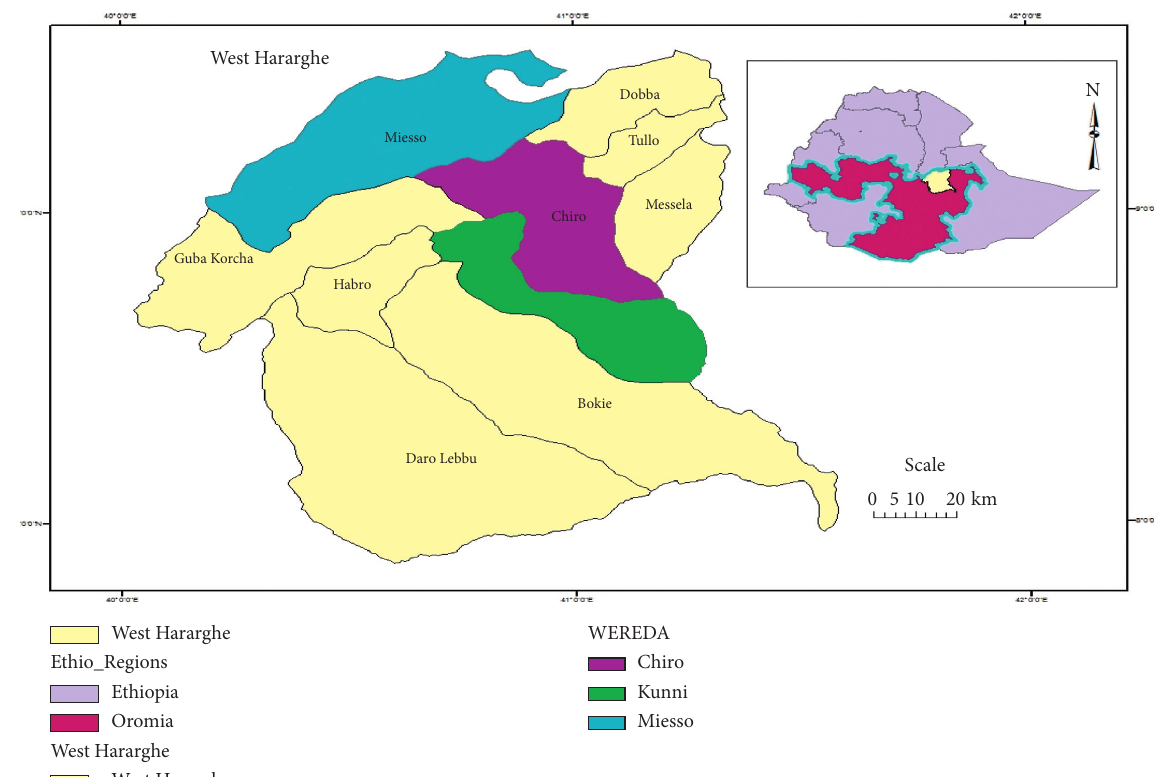
Figure 1: Study areas (by Umer